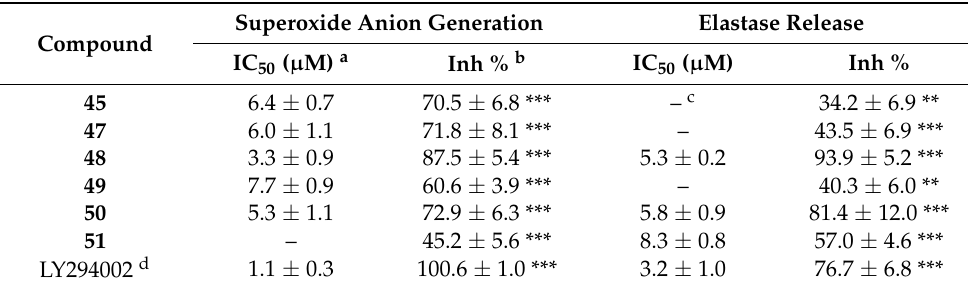
Table 2. Inhibitory effects of purified compounds on superoxide anion generation and elastase release by human neutrophils in response to fMLF/CB.